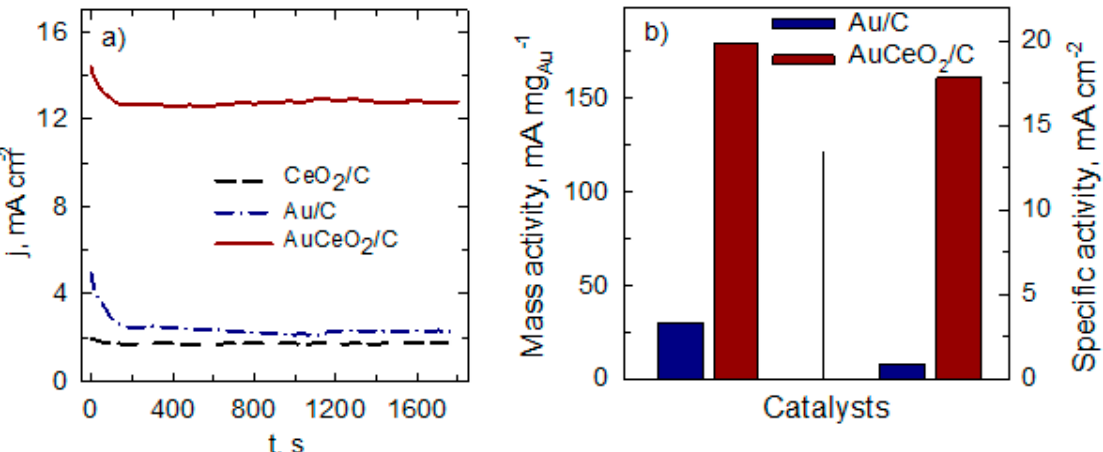
Figure 5. Chronoamperometric data of the investigated catalysts studied in a 0.05 M BH 4 ˉ + 1 M NaOH solution at the potential value of − 0.26 V ( a ), mass, and specific activity of the AuCeO 2 /C and Au/C catalysts calculated from the current density values at the end of the experimental period ( b ).